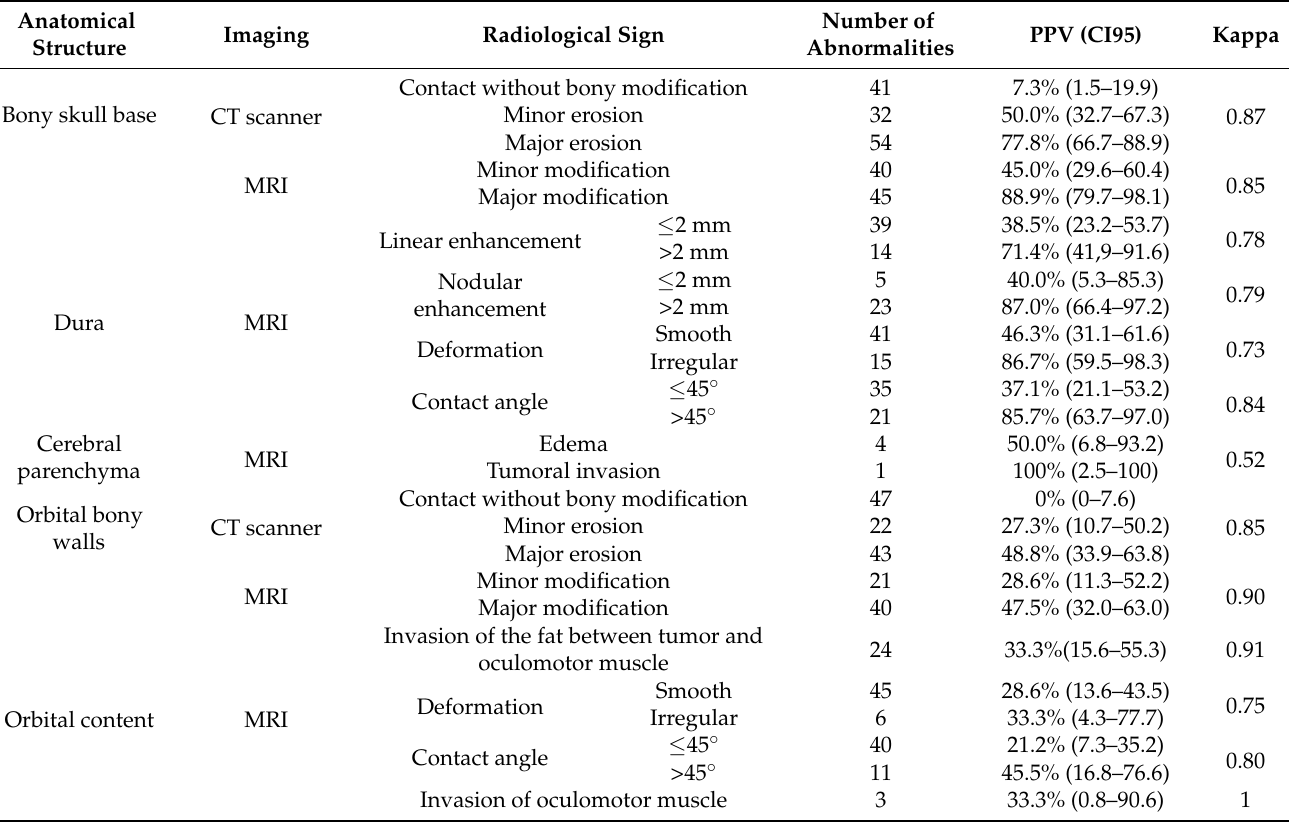
Table 3. Radiohistological correlation.